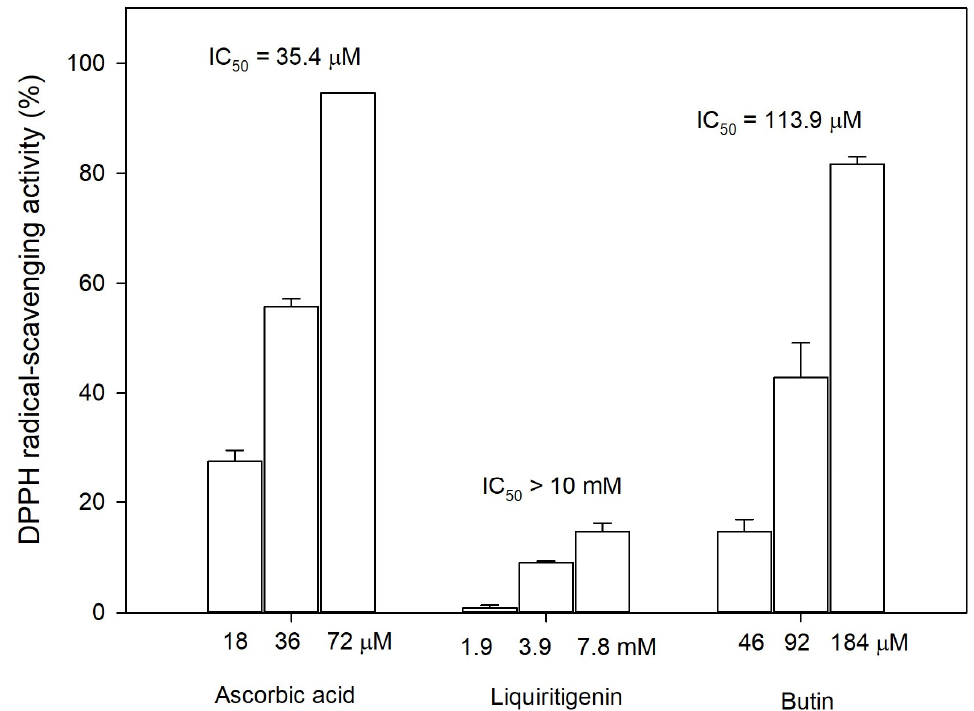
Figure 7. 1,1-Diphenyl-2-picrylhydrazine (DPPH) free radical-scavenging activity of liquiritigenin, butin, and ascorbic acid. The determination of the DPPH scavenging activity is described in Section 3.9. The mean ( n = 3) is shown, and the standard derivative values were represented by error bars. The IC 50 values represent the concentrations required for 50% DPPH free radical scavenging activity.